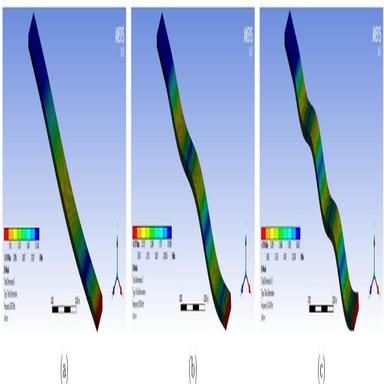
3D visualization of the cantilever beam's bending mode shapes using ANSYS program: (a) 2nd, (b) 4th and (c) 6th bending modes. The fixed end of the beam is colored with deep blue and it is the upper left part in each 3D graph. (For interpretation of the references to color in this figure legend, the reader is referred to the web version of this article.)